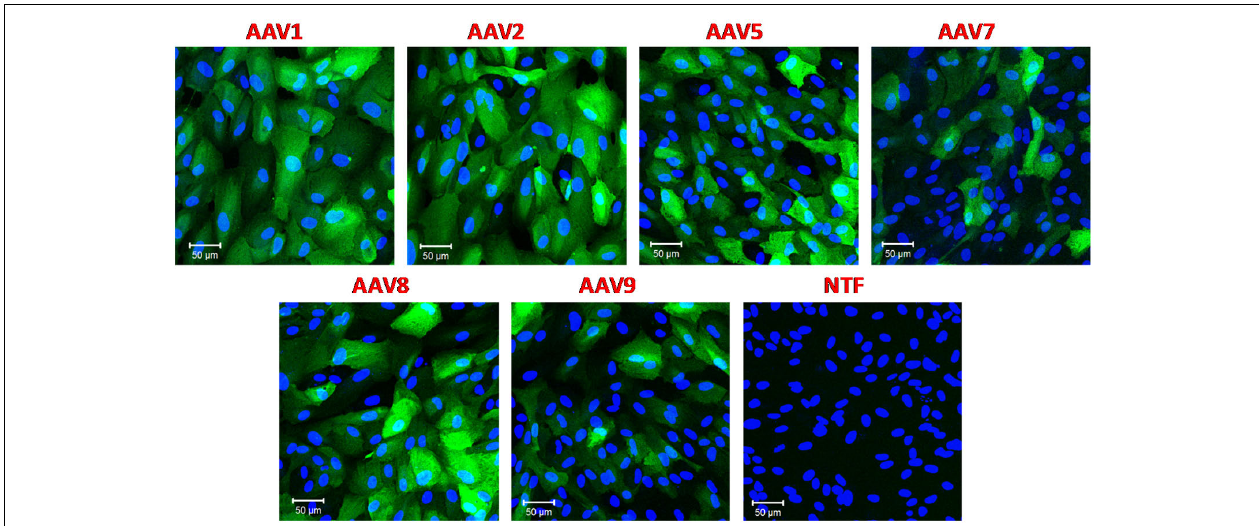
FIGURE 2 | Transduction of immortalized human retinal pigmented epithelial cell line (ARPE-19) with six different rAAV serotypes. ARPE-19 cells were transduced with 10 5 gc/cell of either rAAV1, rAAV2, rAAV5, rAAV7, rAAV8, or rAAV9, as indicated, for 72 h. Infected cells were visualized with rabbit anti-GFP antibodies, and counterstained with DAPI. Control non-transfected cells (NTF) were processed at the same time and in the same fashion. Images are representative of three replicates and were captured using Zeiss LSM510 META confocal microscope at identical exposure settings at 250 × magnification. Scale bars = 50 µ m.